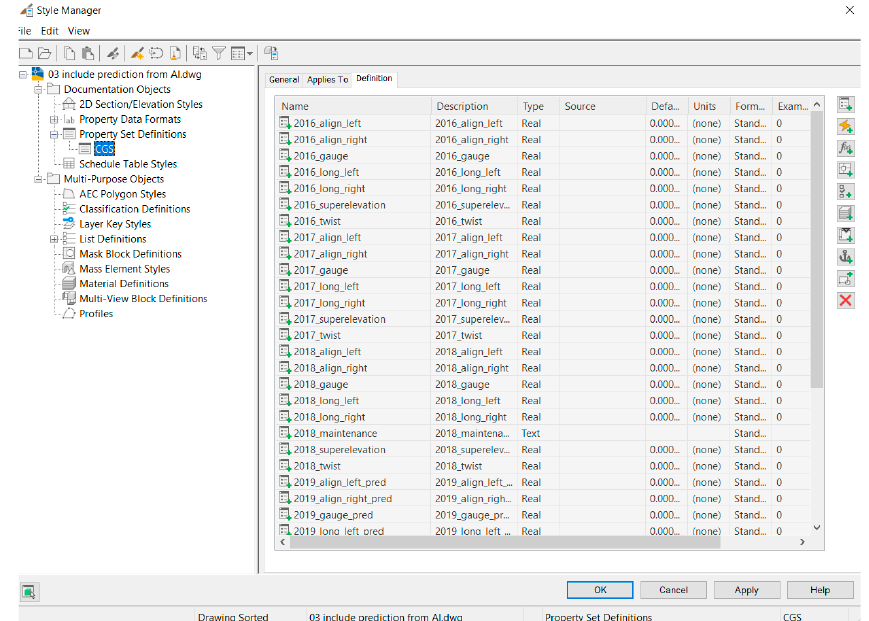
Figure 2. Property set definitions.